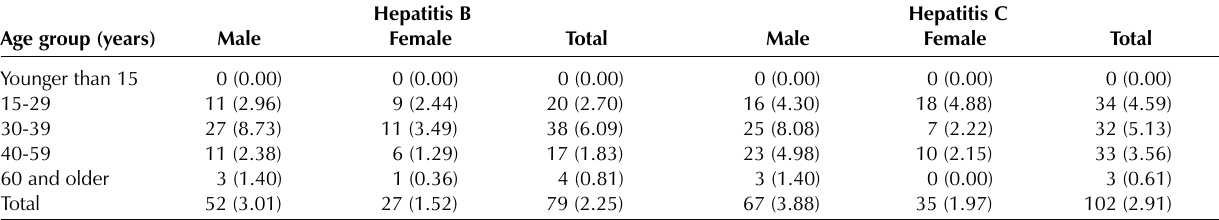
Number of acute or likely acute hepatitis B and C, and incidence rate* in four health regions, 1998 to 1999